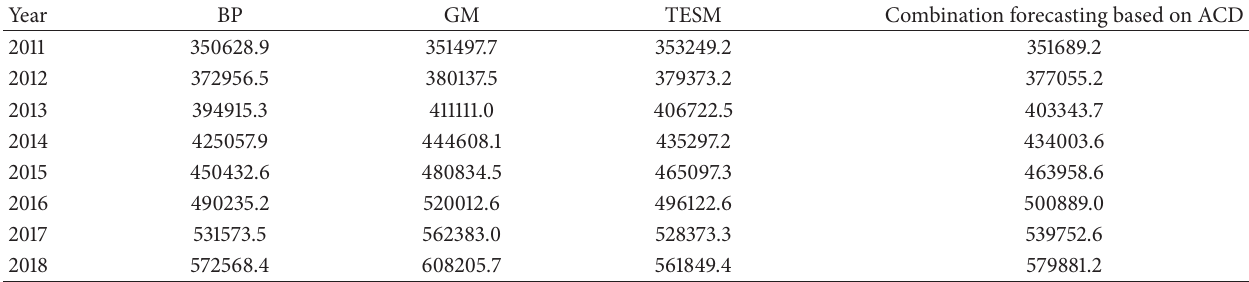
Table 5: Forecasting results of China’s energy consumption by combination model (BP, GM, and TESM) based on ACD in 2011 ∼ 2018 (unit: ten thousand tons of standard coal). BP GM